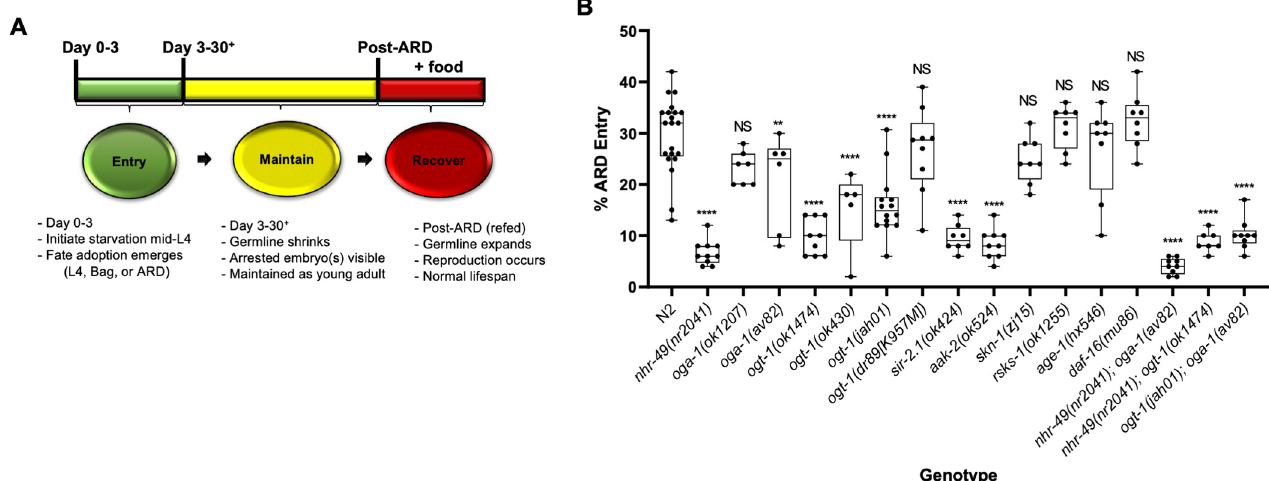
Fig 1. ARD stages and entry defects in nutrient sensing mutants. (A) ARD stages including initiation, remodeling/maintenance, and recovery. Initiation occurs when worms are removed from a food source during mid-L4. With wild type worms, approximately 1/3 enter ARD, 1/3 have hatched offspring inside (bagging), and 1/3 maintain an L4 state during the first 72 hours of starvation. Once ARD is initiated, worms enter the maintenance phase wherein the germline shrinks and the characteristic retained embryo(s) are observed. Recovery occurs after starved worms are re-fed. During this stage the germline expands and a normal lifespan commences (adapted from [13]). (B) The percentage of worms entering ARD as opposed to bagging or L4 fate were quantified for the respective mutants. For single mutants ARD initiation was significantly defective in the following strains, as compared to N2: nhr-49(nr2041 ), aak-2 (ok524) , oga-1(av82) , ogt-1(jah01) , ogt-1(ok430) , ogt-1(ok1474) , and sir-2 . 1(ok424) . The double mutants nhr-49(nr2041);oga-1(av82) , nhr-49(2041);ogt-1 (ok1474) and ogt-1(jah01);oga-1(av82) also showed low ARD entry. A minimum of 300 worms from 3 different experiments were counted and statistics were performed in Graph Pad Prism using an Ordinary one-way ANOVA. P- value ���� = < 0.0001, �� = 0.001, NS = not significant. Box and wisker plots show median, quartiles, and range.